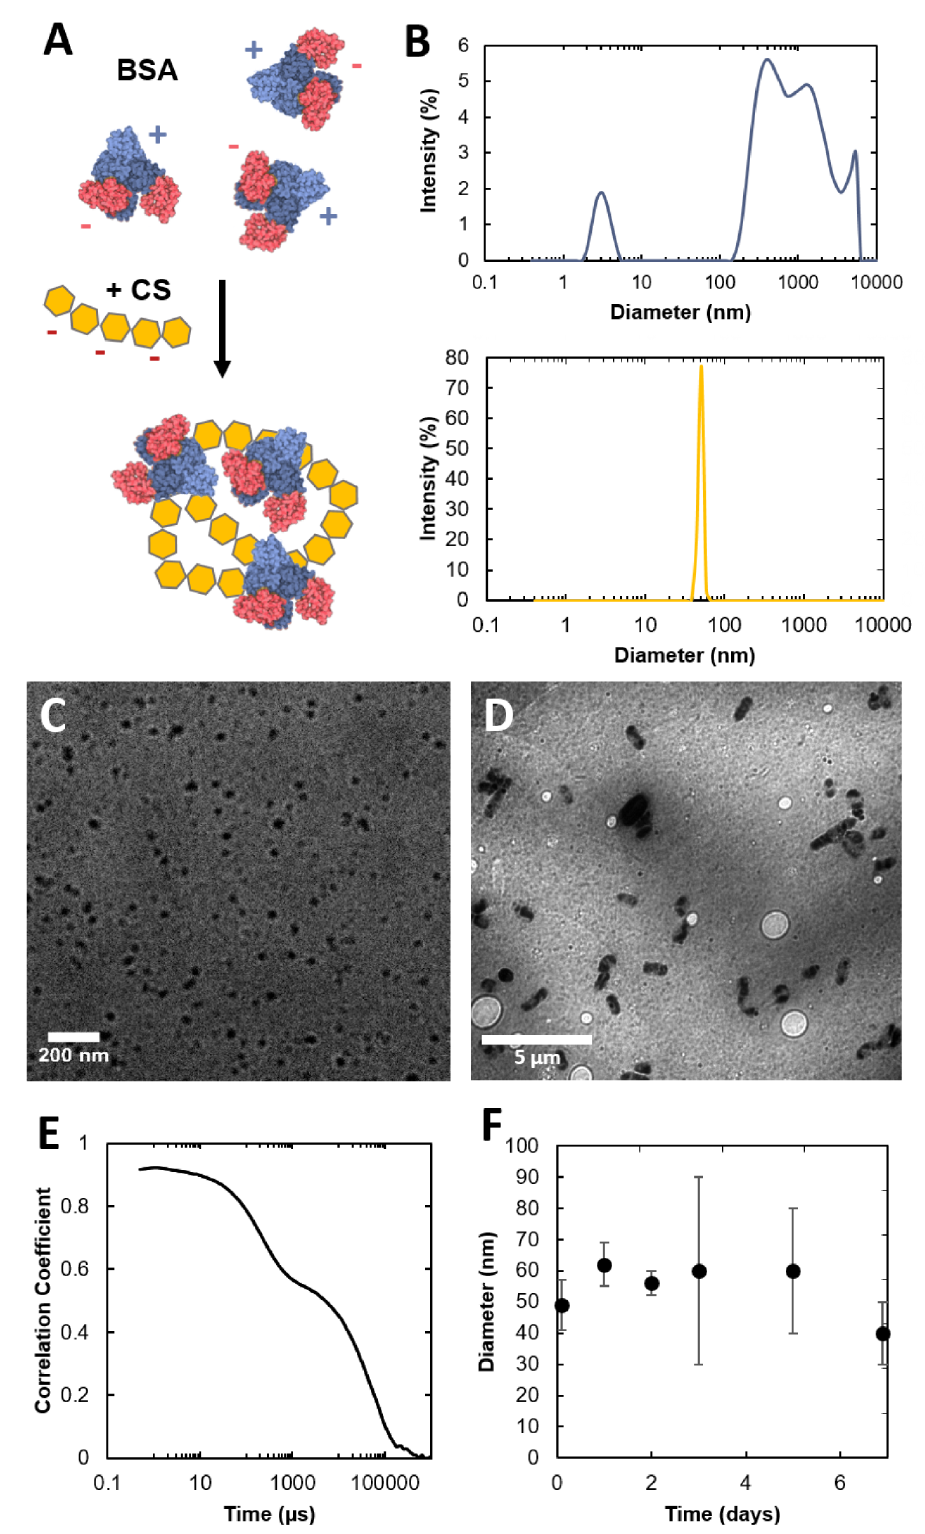
Figure 2. Self-assembly of chondroitin sulfate (CS) and bovine serum albumin (BSA) particles. ( A ) Schematic of the formation of dense CS-BSA particles. ( B ) DLS size plot of dynamic BSA aggregates (top) and CSBSA particles (bottom). ( C – D ) TEM image of CS-BSA nanoparticles ( C ) and microparticles ( D ). ( E ) Autocorrelation function of CS/BSA NPs. ( F ) Time resolved DLS of CS/BSA NPs. Dataset 1: Dynamic light scattering and transmission electron microscopy data 20 .